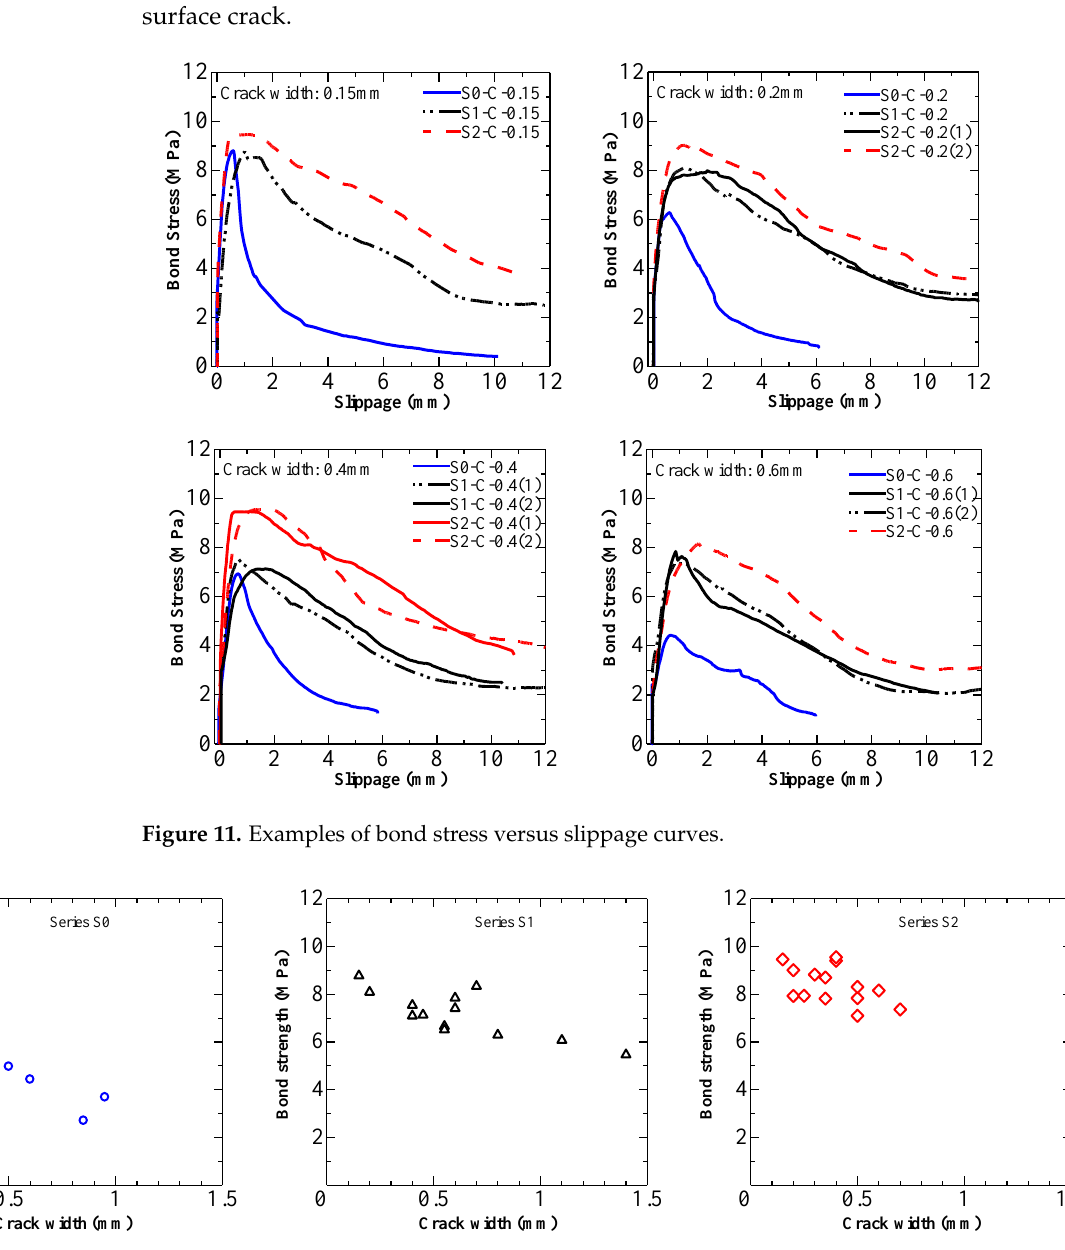
Figure 12. Bond strength-induced crack width relationship: ( a ) Serie S0; ( b ) Serie S1; ( c ) Serie S2.